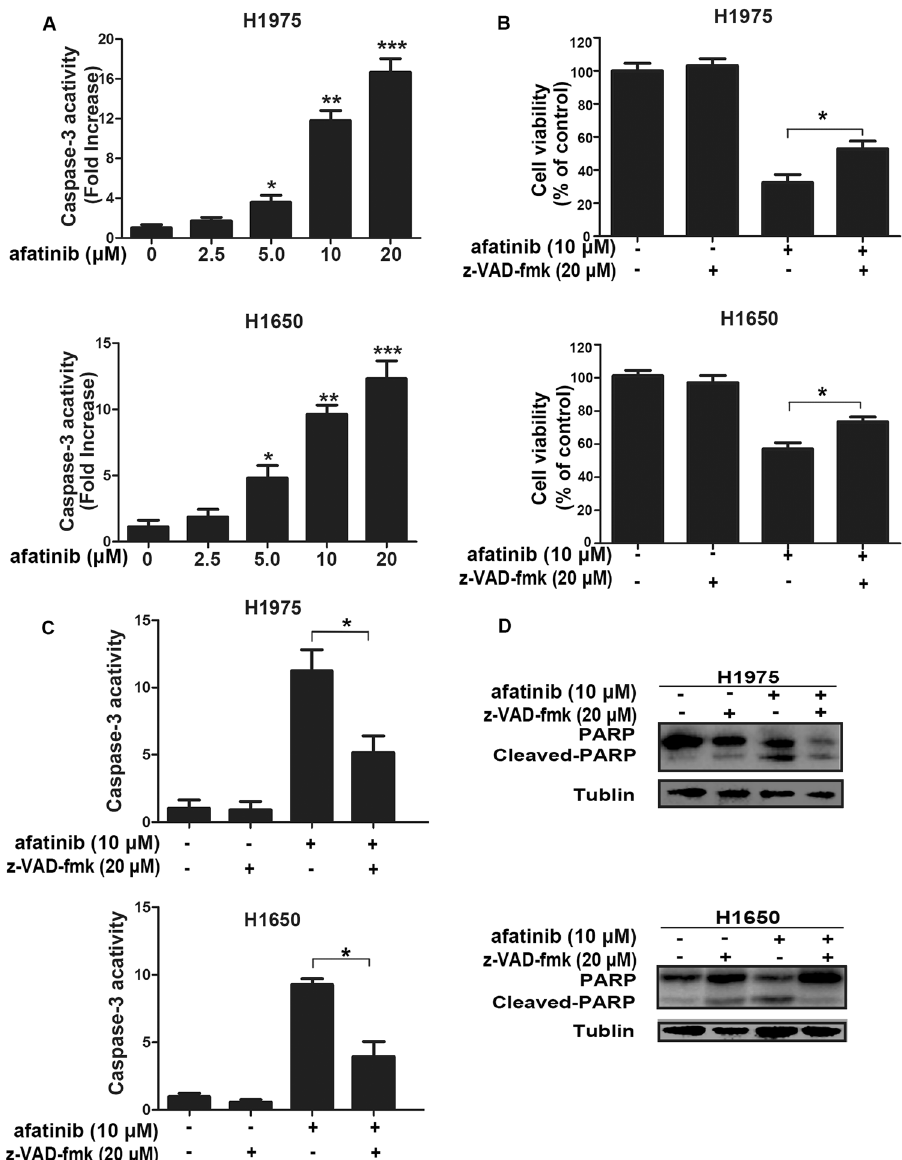
Figure 2. Afatinib-induced apoptosis is partially caspase 3-dependent in H11975 and H1650 cells. ( A ) H1975 and H1650 cells were stimulated by indicated concentrations of afatinib for 48 h, then caspase 3 activity was detected by the caspase 3 activity kit. Data were represented as mean ± SD ( * P < 0.05, ** P < 0.01, *** P < 0.001 versus control) ( B – D ) H1975and H1650 cells were treated with 10 μ M afatinib in the absence or presence of 20 μ M z-VAD-fmk for 48 h. ( B ) Cell viability was measured by MTT assay at 570 nm. ( C ) The activity of caspase 3 were determined by the caspase 3 activity kit. All data were represented as mean ± SD ( * P < 0.05). ( D ) The levels of PARP and cleaved-PARP were measured by western blot analysis. These blots were cropped with Photoshop